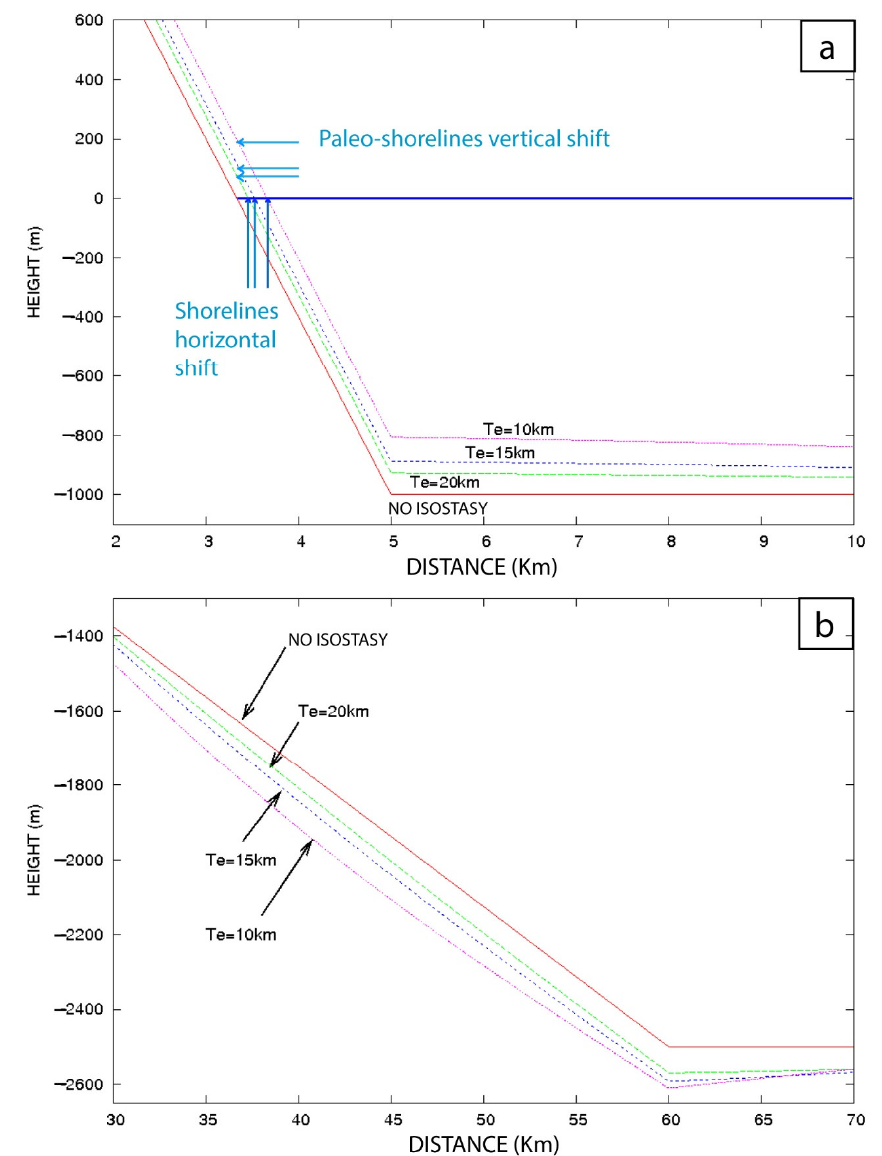
Figure 4. Insert of Figure 3. Positions of the surface of the volcano after isostatic adjustment with different T e . Details of vertical movements for T e = 10 km, T e = 15 km, and T e = 20 km. ( a ) Isostatic adjustment of the coastline after the large landslide that occurred on Tahiti approximately 872 kyr ago. The relict shorelines after isostatic adjustment are represented by blue horizontal arrows for each elastic thickness T e . The new shorelines, after that isostatic response takes place, are represented by blue vertical arrows. ( b ) The detailed distal part of the volcano where the landslide deposits are located and subsidence occurred. The red line represents the topography of the volcanic island without isostatic deformation. The slope around the coast in the area where the landslide occurred is ~12 ◦